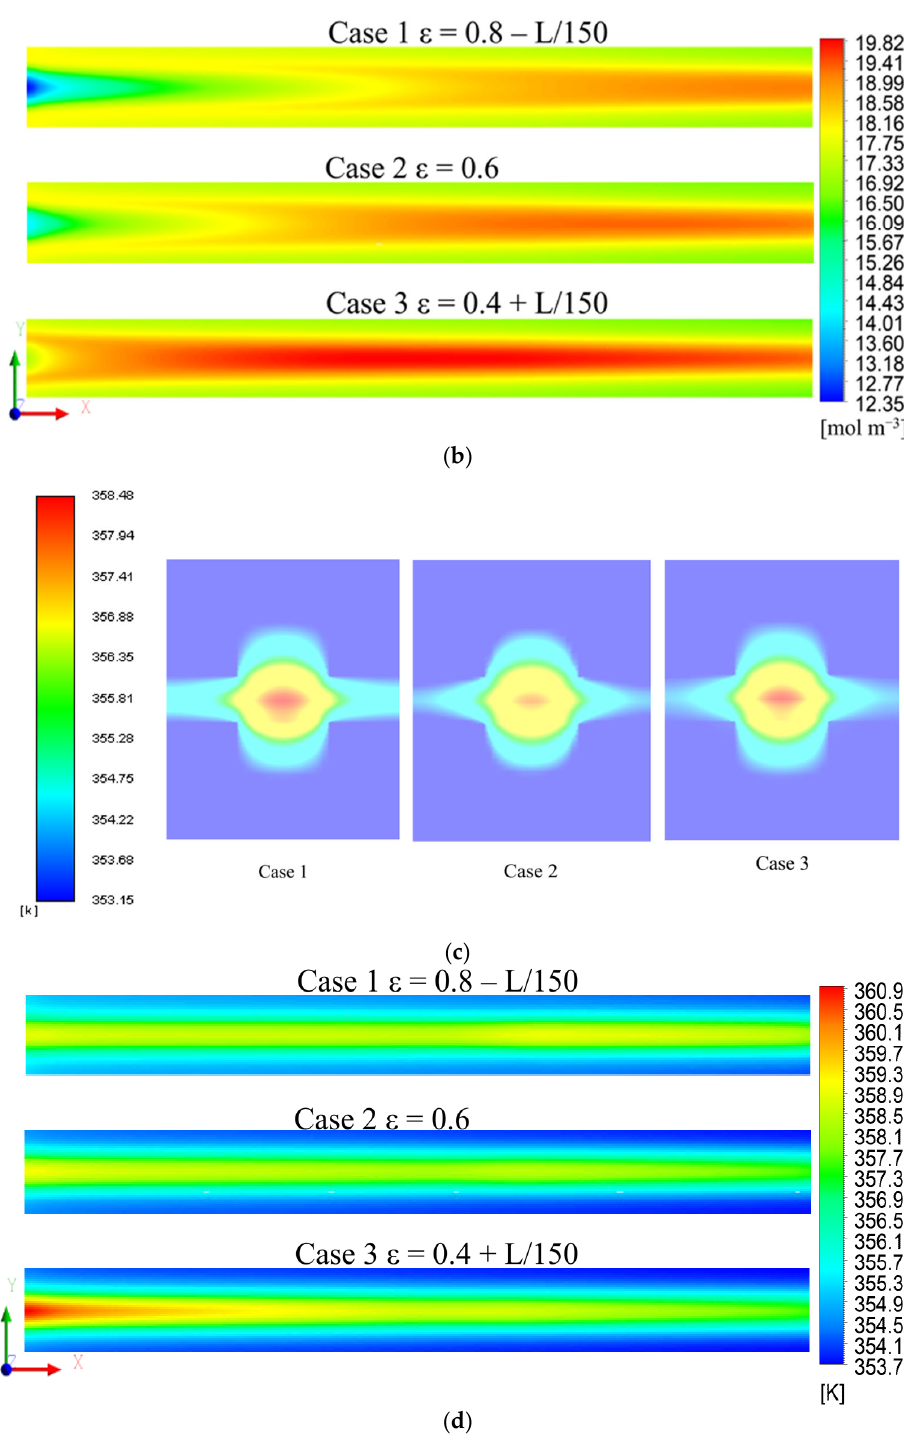
Figure 7. ( a ) Distribution of water vapor molar concentration at the 1/2 thickness of the cathode GDL, ( b ) Distribution of water vapor molar concentration at the 1/2 thickness of the cathode CL, ( c ) Distribution of temperature in the cross-sections at 1/2 of the cell length, ( d ) Distribution of temperature in the sections at the 1/2 thickness of the cathode